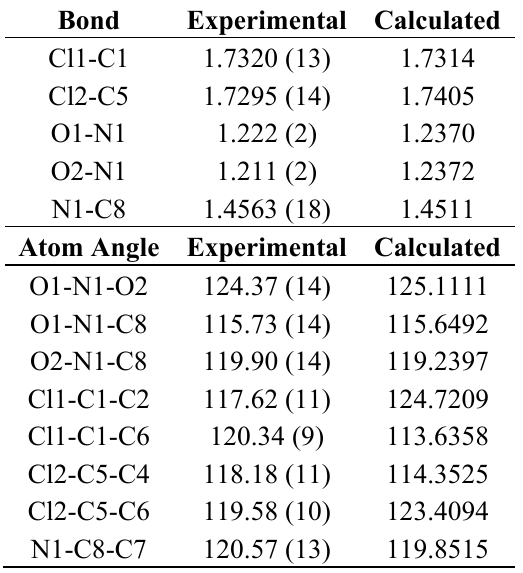
Table 2. Selected geometric parameters (Å, °) of compound 1a .